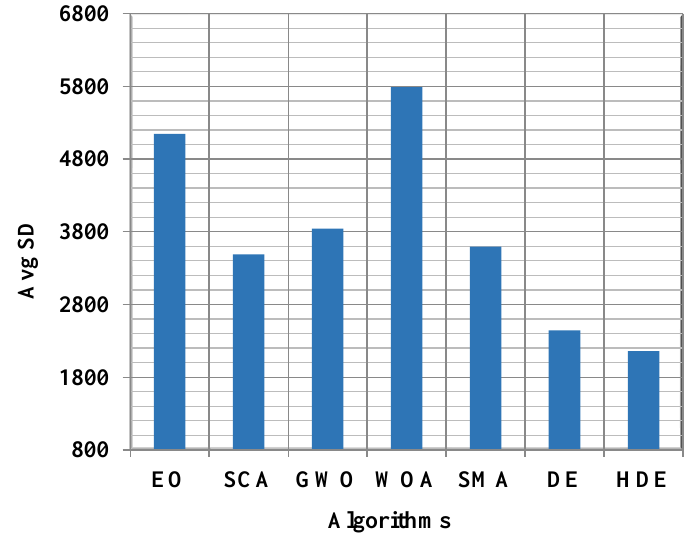
Figure 9. Comparison in terms of the average SD of total execution time.